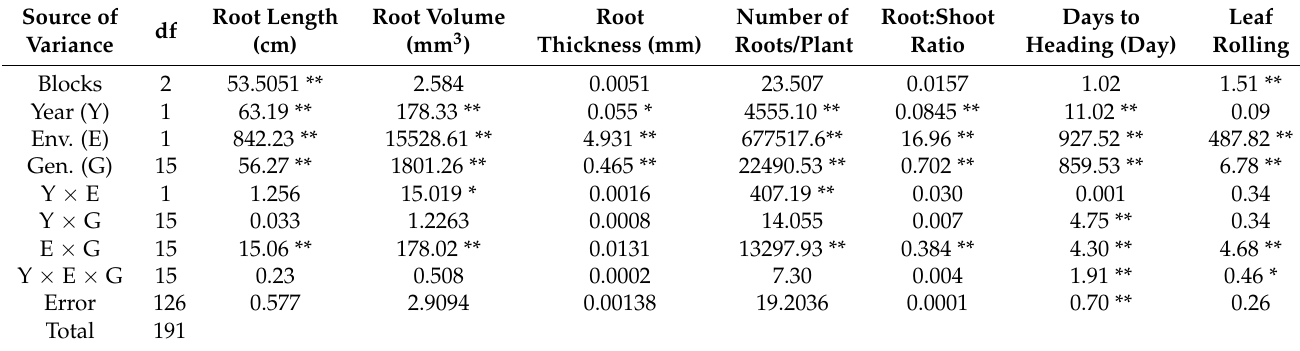
Table 4. Analysis of variance for growth characteristics under normal and drought conditions. Source of